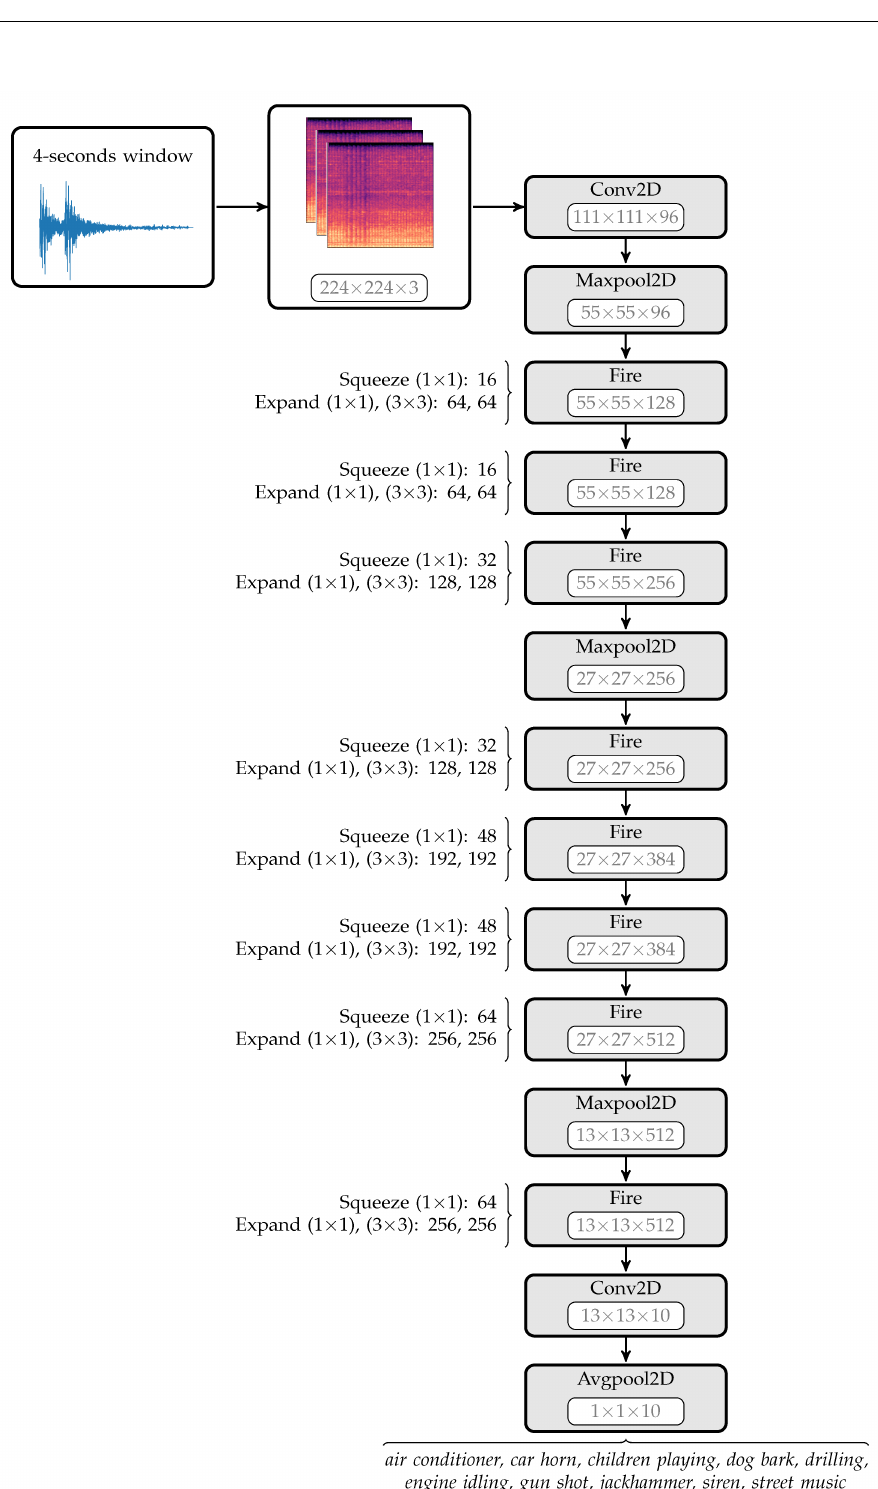
Figure 11. An example schematic for modelling DAS data using a preprocessed spectrogram plot on CNN-based models. Reprinted from ref.